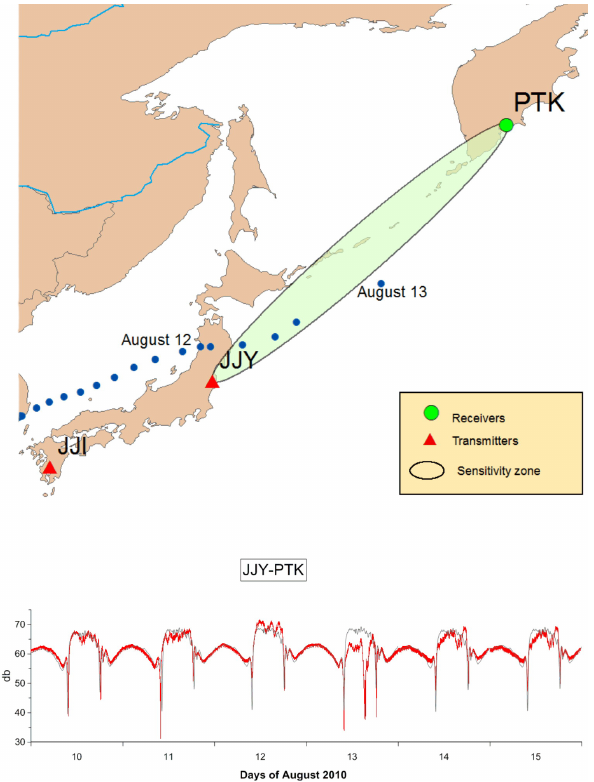
Figure 4. The bottom panel shows an example of anomaly in the JJY signal recorded at the PTK station during the passage of the TC Dianmu (1004). Red and black lines are the observed and averaged signals, respectively. Blue solid circles in the top panel illustrate the position of the TC centres on 12–13 August 2010.